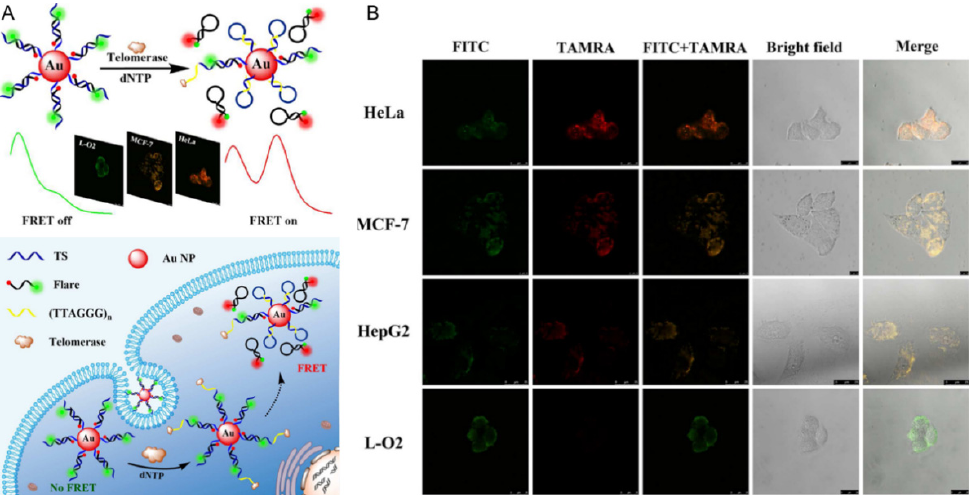
Figure 5. ( A ) Schematic of FRET probe for ratiometric imaging of intracellular telomerase. ( B ) Confocal images of HeLa, MCF-7, HepG2, and L-O2 cells after incubation with 30 μ L of probe for 5 h. Reproduced from [67], with permission from the American Chemical Society, 2017.